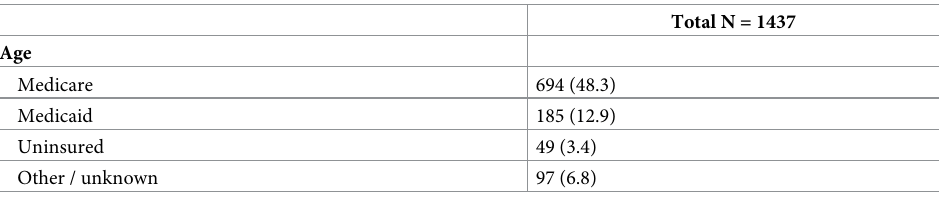
PLOS ONE | https://doi.org/10.1371/journal.pone.0272740 August 5,